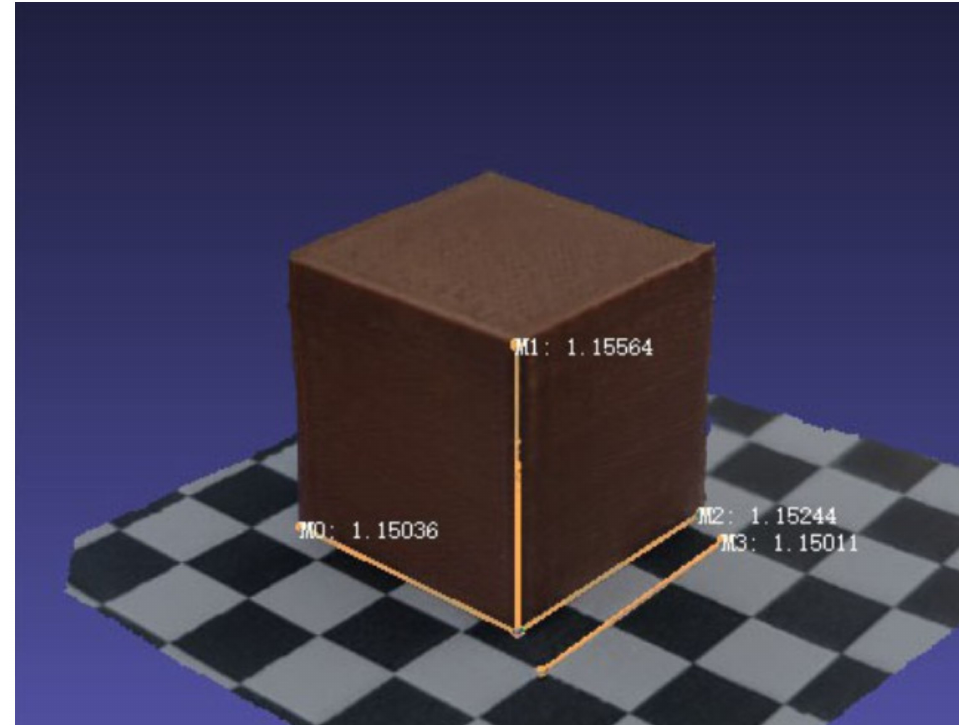
Figure 14. Accuracy analysis of reconstruction